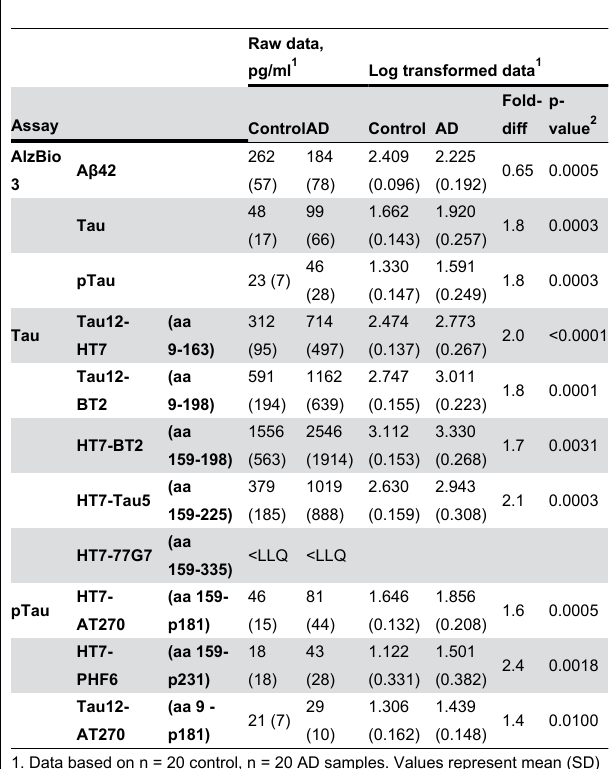
Table 3. Summary of analysis of 20x20 CSF sample